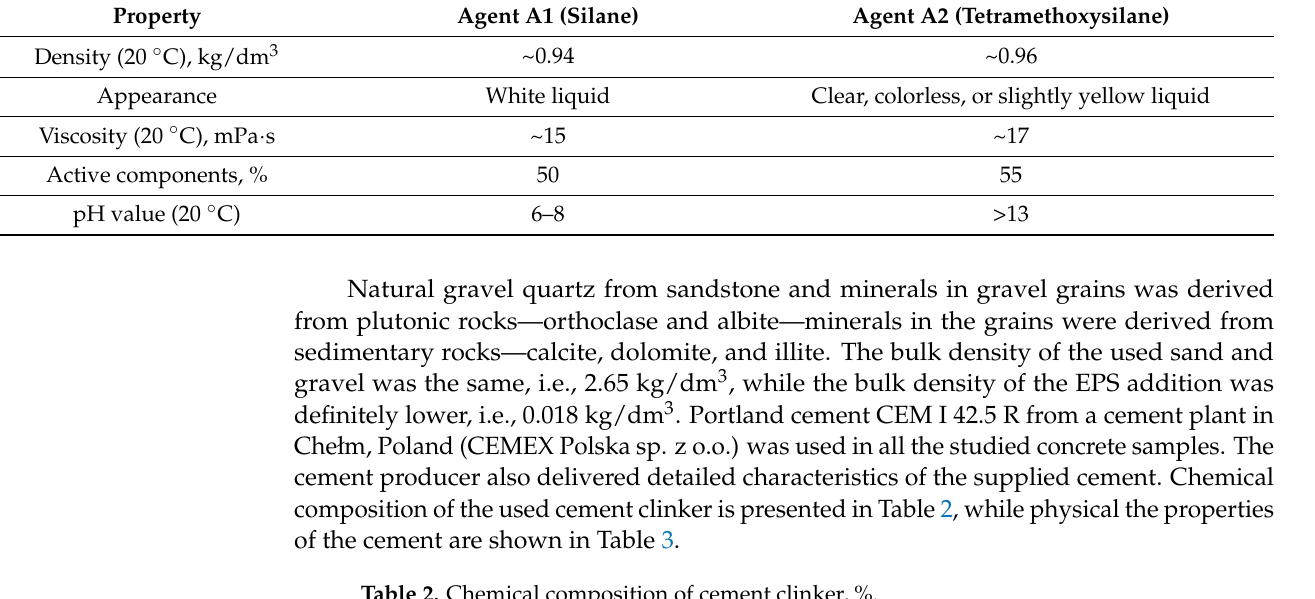
Table 2. Chemical composition of cement clinker, %.